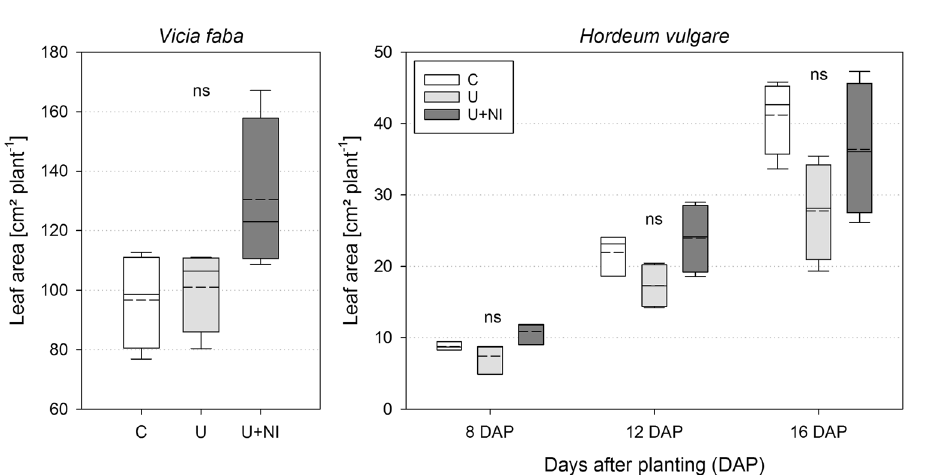
Figure 5. Leaf area for Vicia faba (left) after 16 days and for Hordeum vulgare (right) over time for the treatments control (“C”), urea (“U”) and urea with nitrification inhibitor (“U+NI”). Significant differences ( p < 0.05) between treatments for each point in time are indicated by different letters, ns = not significant; dashed lines in the boxplots represent mean values while solid lines represent the